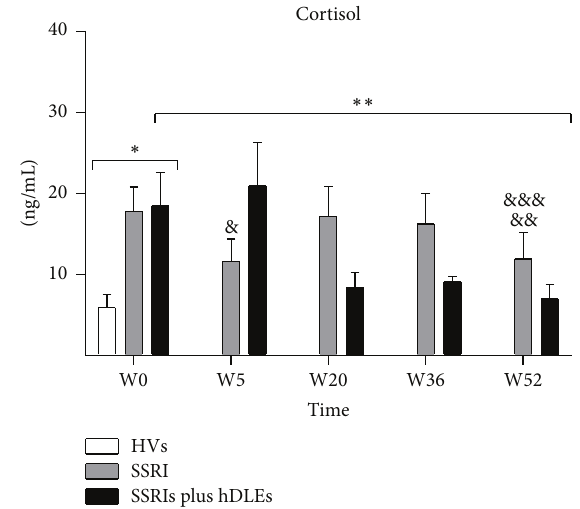
Figure 2: 24 h urinary cortisol levels detected by RIA in healthy volunteers and MDD patients. Patients were treated with SSRIs or SSRIs plus hDLEs during 52 weeks of study. The statistical analyses were as follows. First, the patient group before antidepressant treatment (W0) was compared with the control group (HVs). Second, the values before the antidepressant treatment (W0) were compared with those during the treatment (W5, W20, W36, or W52) in patients. Third, the data of patients at W52 versus HVs were compared. ∗ 𝑃 < 0.0001 , significant difference before treatment versus HVs. ∗∗ 𝑃 < 0.001 between SSRIs plus hDLEs treatment at W5, W20, W36, and W52 versus W0. & 𝑃 < 0.0001 between SSRIs treatment at W5 versus W0. && 𝑃 < 0.05 between SSRIs treatment at W52 versus W0. &&& 𝑃 < 0.05 between SSRIs treatment at W52 versus HVs. Data are expressed as mean ± SD. HVs: healthy volunteers; MDD: major depression disorder; W: weeks.